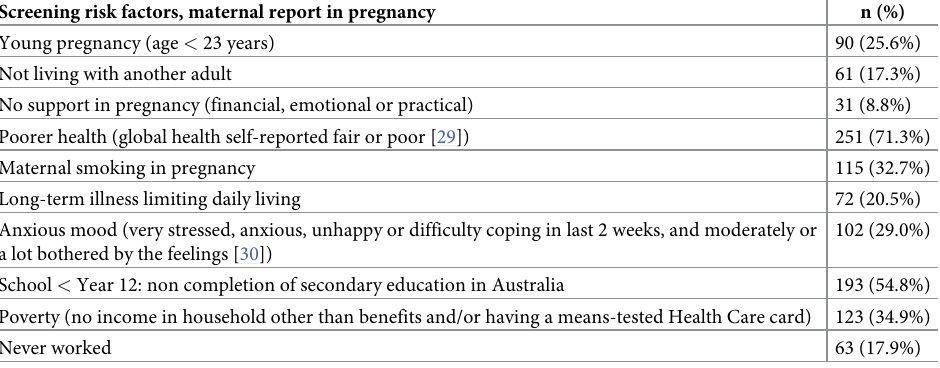
Table 1. Screening data from a 10 question survey: right@home intervention recipients (n = 352). Screening risk factors, maternal report in